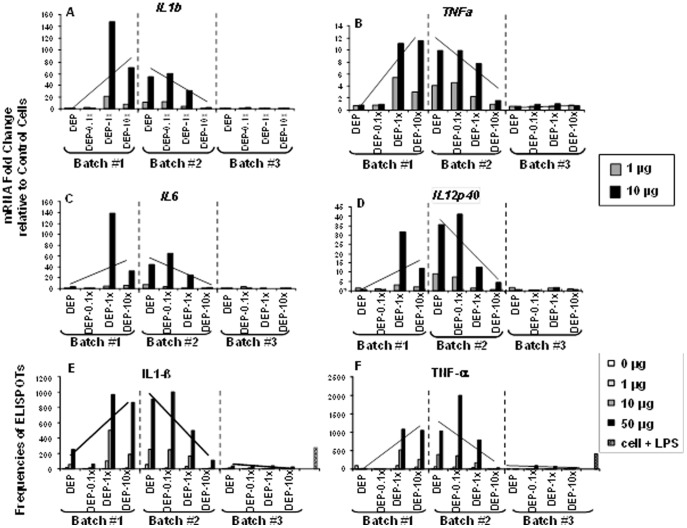
Effects of DEP and DEP-Env Exposure on Cytokine mRNA and Protein Expression in THP-1 Cells.THP-1 cells were exposed to indicated concentrations of DEP, DEP-0.1x, DEP-1.0x, and DEP-10x from three independent batches (#1-3) for 4 hours. The abundance of mRNAs encoding IL1b, TNFa, IL6 and IL12p40 was examined by real-time PCR assays (A, B, C, and
D). Alterations of mRNA levels in THP-1 cells exposed to DEP, DEP-0.1x, DEP-1.0x, and DEP-10x samples are shown as fold changes (y-axes) relative to unexposed (control) THP-1 cells cultured in complete media. THP-1 cells were exposed to indicated concentrations of DEP, DEP-0.1x, DEP-1.0x, and DEP-10x from three independent batches (#1-3) for 24 hours (E and F). Frequencies of IL-1β and TNF-α cytokine-producing THP-1 cells were assessed by ELISPOT assay. The y-axes represent frequencies of cytokine-producing cells. To demonstrate the change in the expression profile of mRNAs encoding IL1b, TNFa, IL6 and IL12p40 and of IL-1β and TNF-α-producing cells exposed to DEP and DEP-0.1x, DEP-1.0x, DEP-10x from batch #1-3, straight lines indicating the trends are inserted.